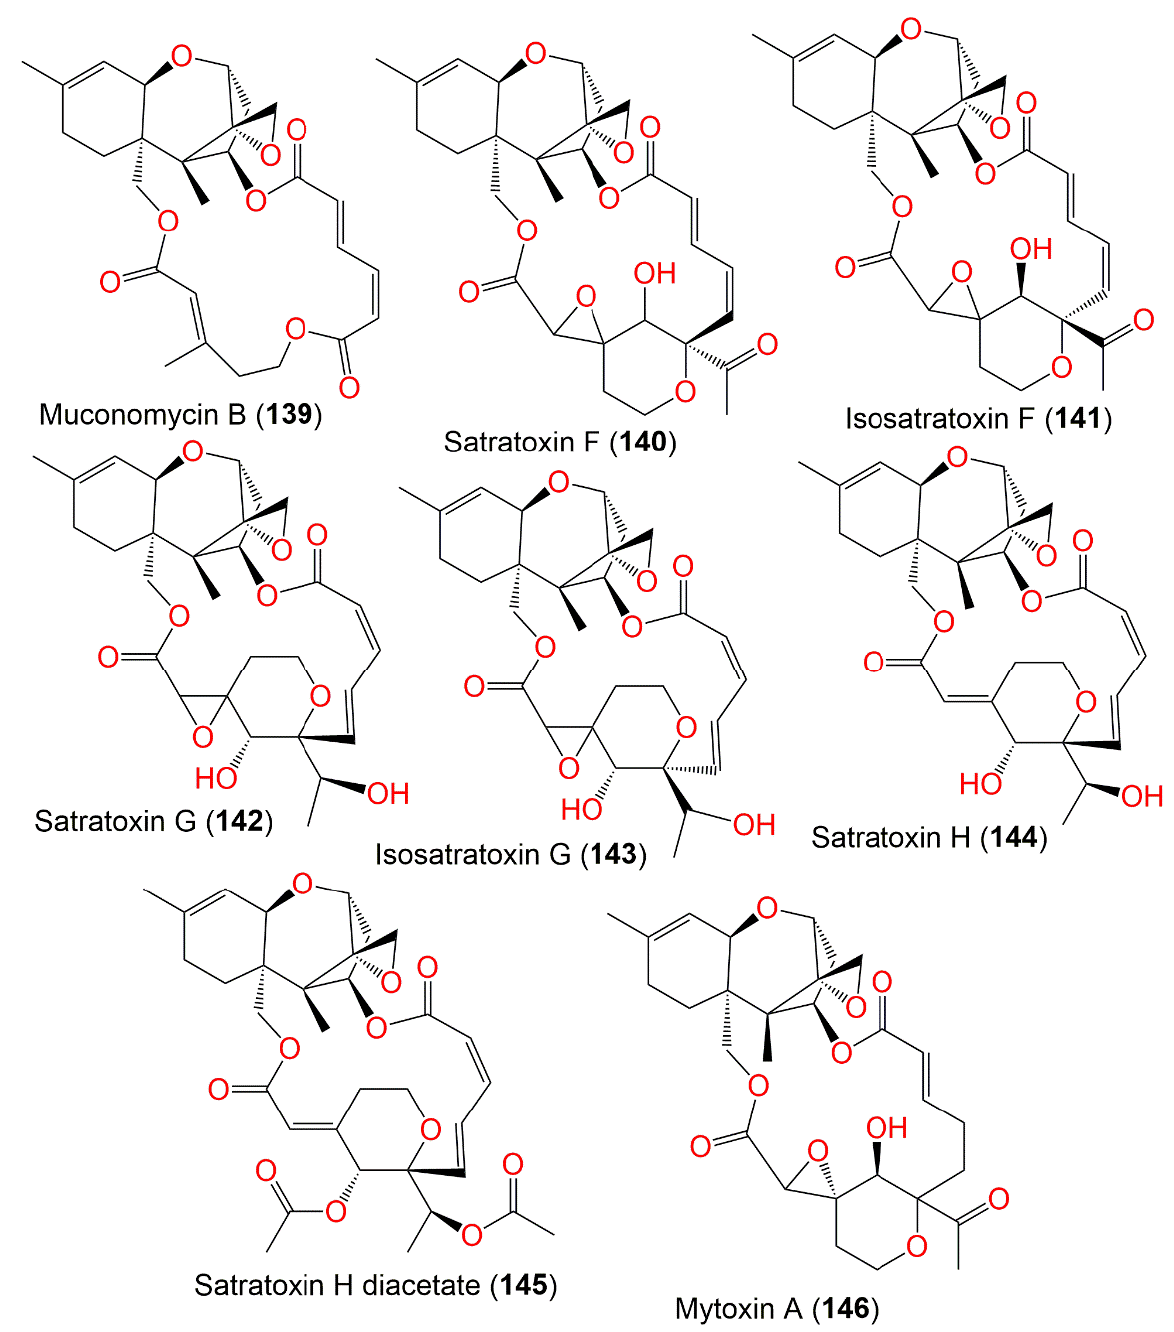
Figure 18. structures of trichothecenes ( 139 – 146 ) reported from S . chartarum . Figure 18. Structures of trichothecenes ( 139 – 146 ) reported from S . chartarum . The apotrichothecene-related analogs, 117 with a C-12 sugar and without C-4 and C- Satratoxin F ( 140 ) and satratoxin H ( 144 ) were separated by Yang et al. using RP-18 2 hydroxy group (IC 50 2.38–3.95 μ M) or 118 with a C-2 methoxy group, had a weaker in- and HPLC CC. Compound 140 displayed moderate inhibitory activity against methicillin- fluence than that of the 2,4,12-trihydroxy analog, 116 (IC 50 0.65–0.87 μ M). On the other resistant S. aureus ATCC-29213 (MIC 39 µ g/mL) [73]. Besides, 140 (IC 50 s < 39 nM) displayed side, trichodermol-type analogs, having a macrocyclic ring alongside a tetrahydropyran strong cytotoxic potential versus MDA-MB-231, C4-2B, MGC803, MDA-MB-468, and A549 ring (e.g., 142 , 144 , and 146 ), possessed remarkable potential; however, those without a cell lines in the CCK-4 assay tetrahydropyran-attached macrocyclic moiety ( 130 and 139 ) exhibited less cytotoxicity. Compounds 123 , 124 , 128 , and 129 with a C-14 or C-4 linear moiety had reduced effects compared with 146 . Additionally, their antitumor mechanism was investigated versus tu- mor growth-related tyrosine kinases (e.g., FGFR3 (fibroblast growth factor receptor 3), IGF1R (insulin-like growth factor 1 receptor), PDGFRb ( β -type platelet-derived growth